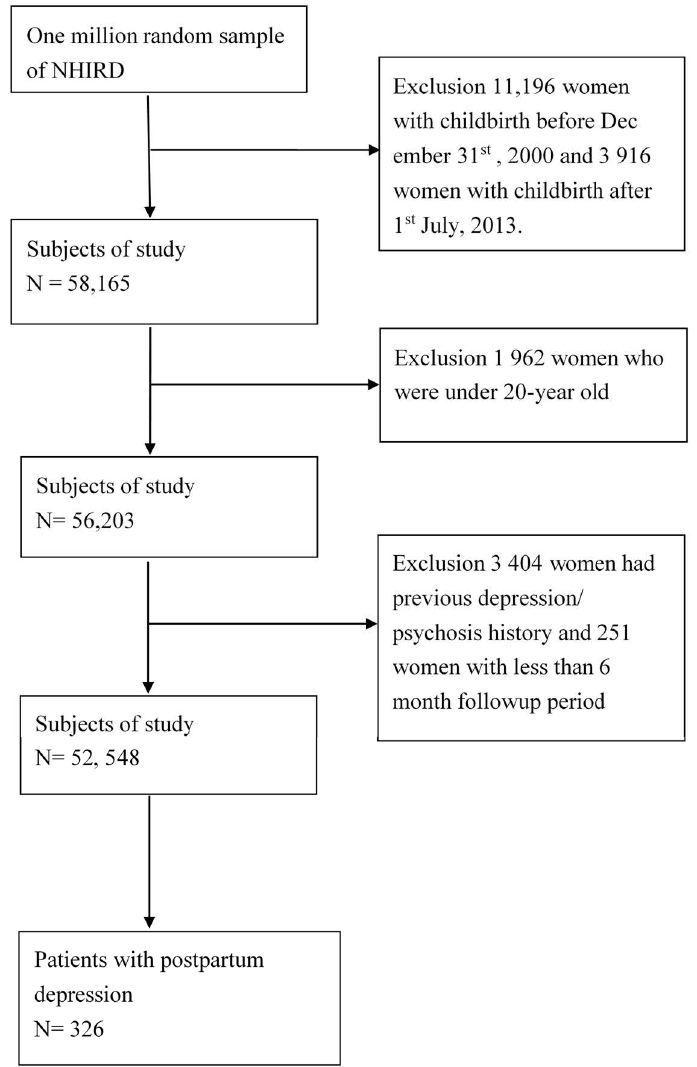
Figure 1. Flowchart of recruitment of subjects from the 1 million random sample of the National Health Insurance Research Database (NHIRD) from 2000 to 2013 in Taiwan.